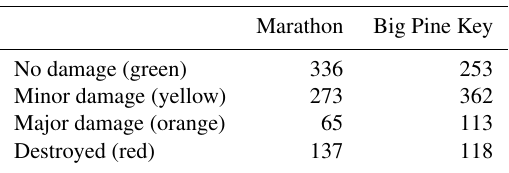
Table 1. The number of buildings assigned into each damage state